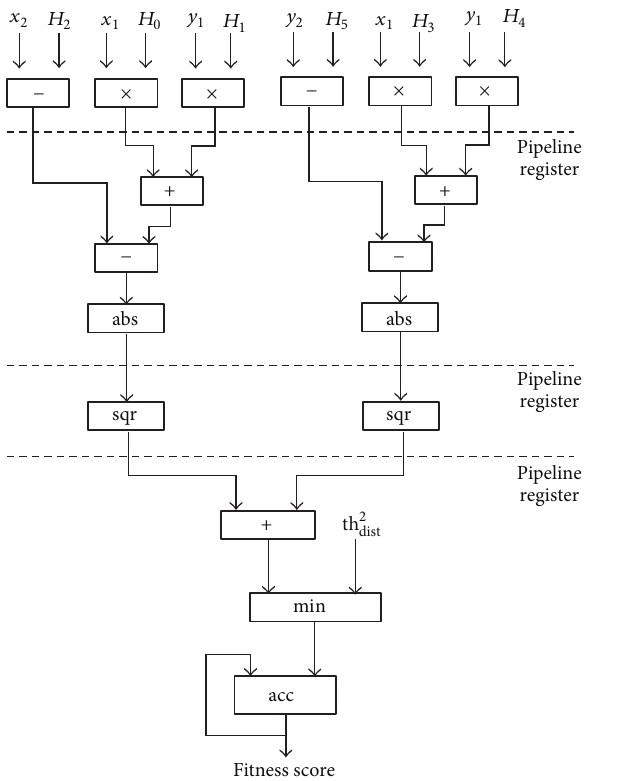
Figure 9: Hardware architecture for object